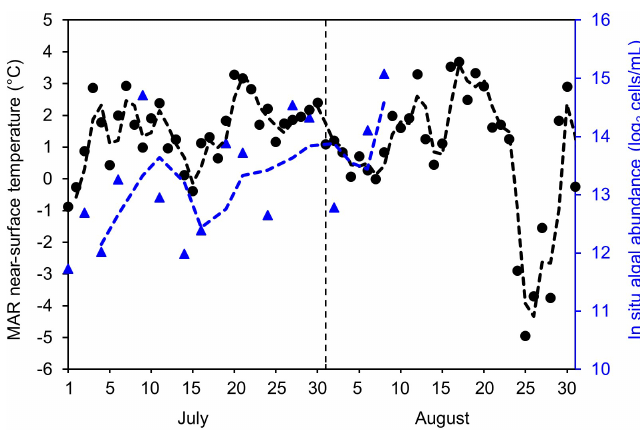
Figure C2. MAR-simulated near-surface air temperature ( ◦ C, black circle, left axis) and in situ measured algal abundance (log 2 cellsmL − 1 , blue triangles, right vertical axis) at the S6 weather station at the K-transect during July–August 2014 by Stibal et al.